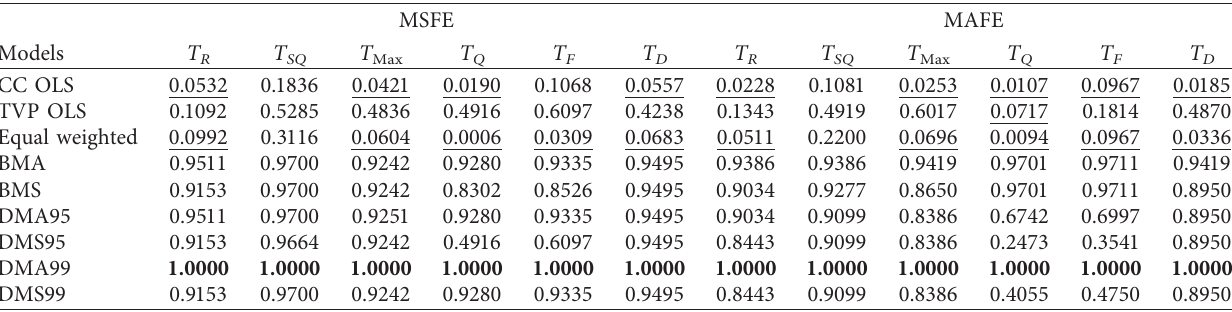
Table 4: Results of the MCS test.